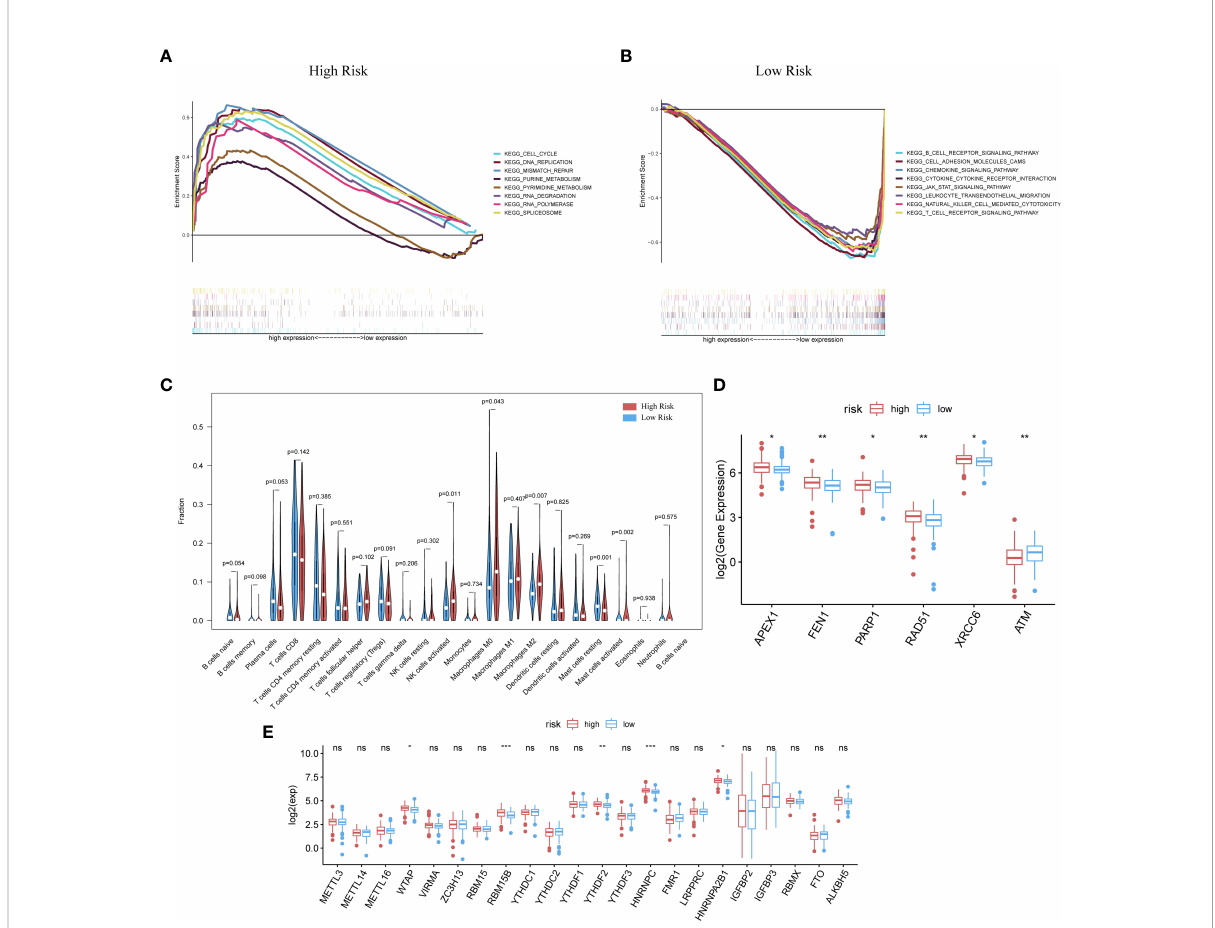
FIGURE 4 GSEA analysis was done under the high-risk group (A) along with the low-risk group (B) . (C) CIBERSORT analysis result got shown in violin plot. (D) Except for ATM, other DDR-related genes with signi fi cantly expressed differences are expressed higher in the cluster with high risk